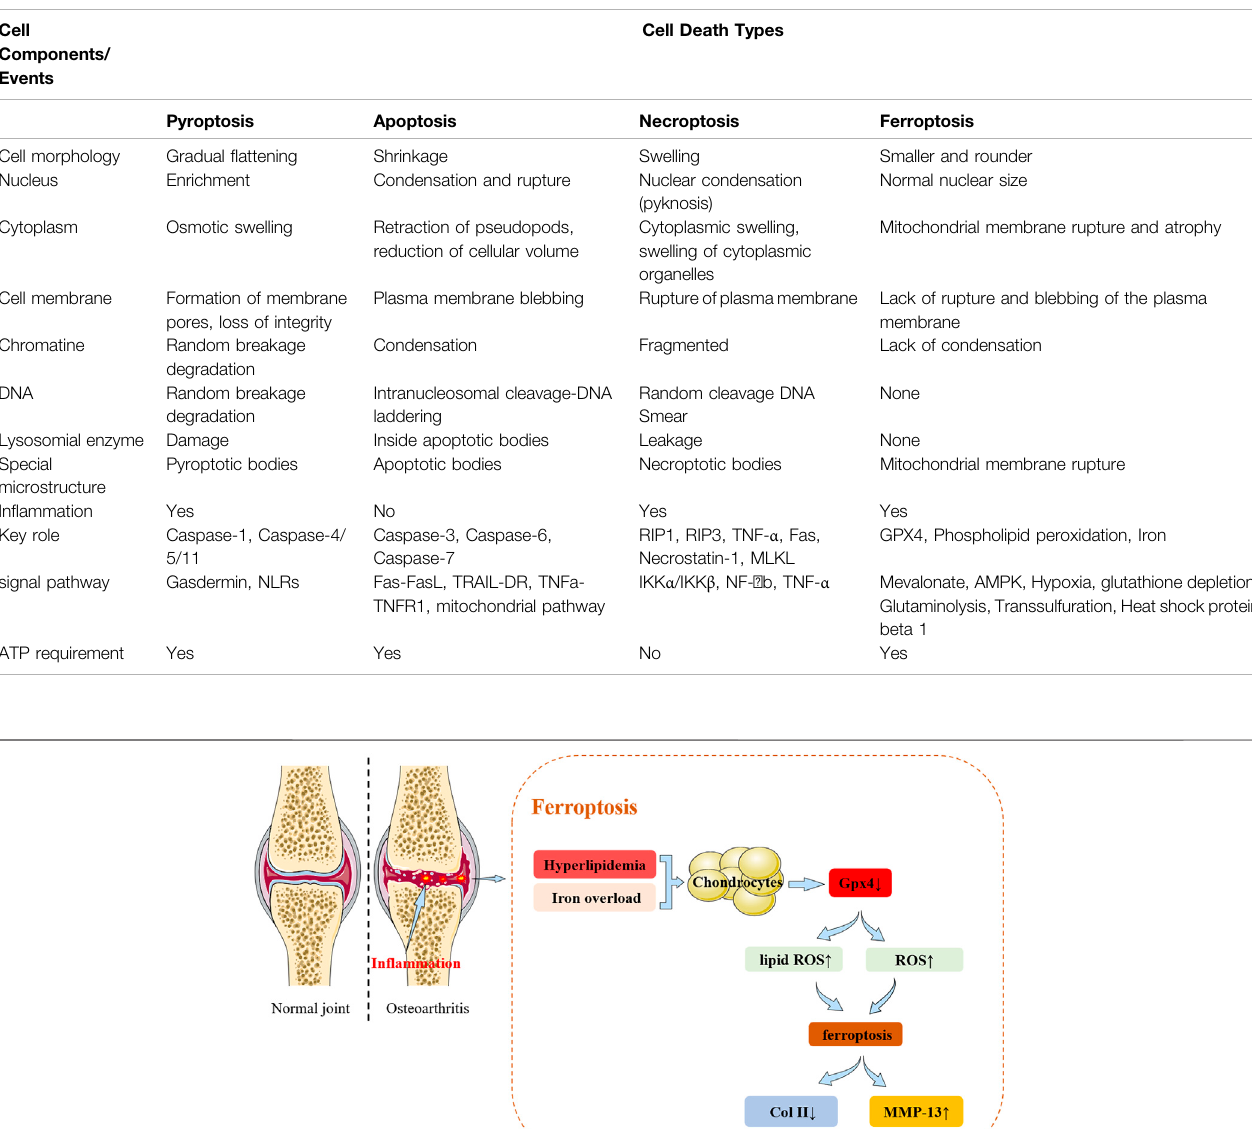
Frontiers in Cell and Developmental Biology |